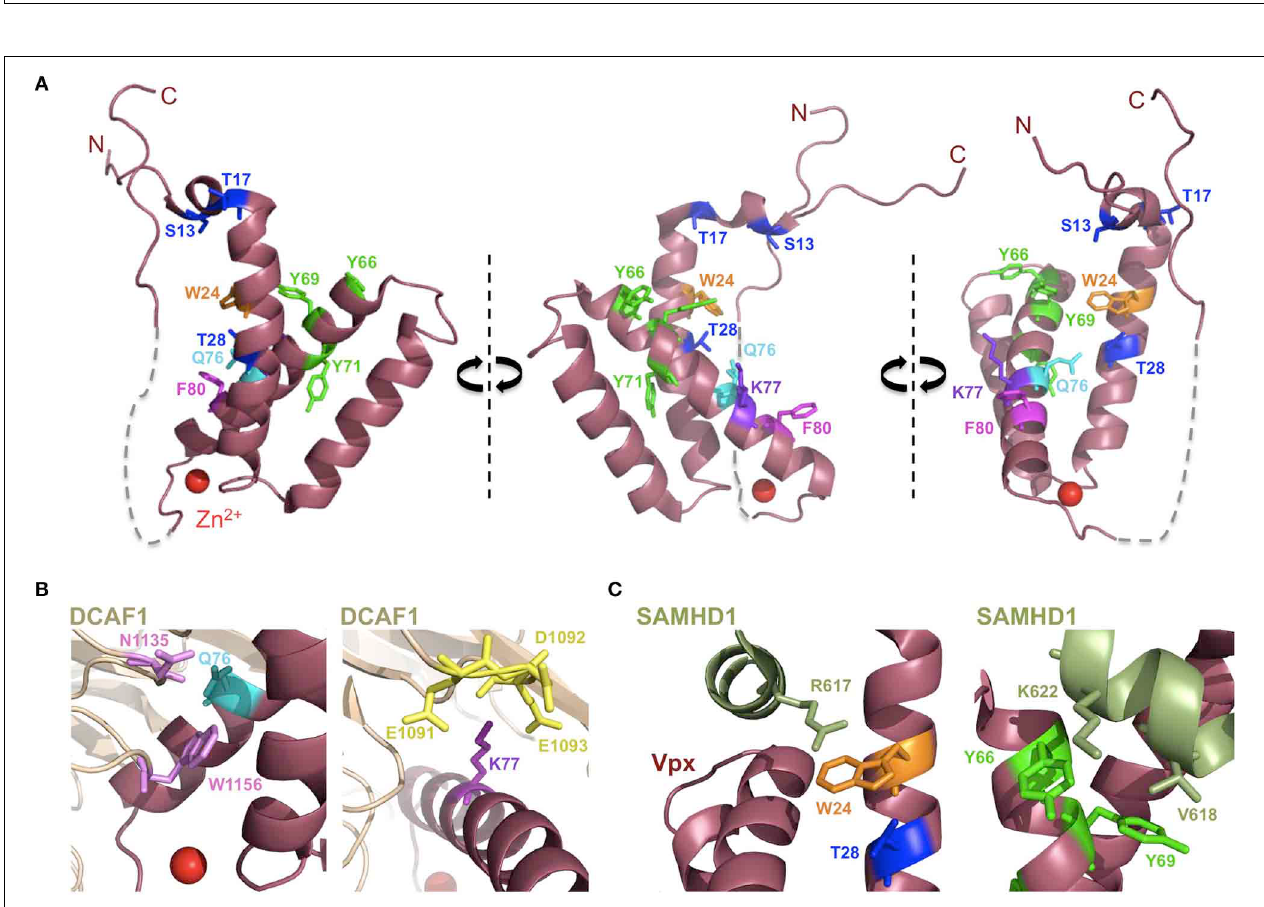
FIGURE 4 | Vpx structure. (A) Depicted is the structure of Vpx from SIVsmm as obtained in the co-crystallization with the C-terminus of DCAF1 and the C-terminus of SAMHD1 (both not shown) with critical amino acids highlighted (PDB:4CC9) (Schwefel et al., 2014). SIVsmm Vpx comprises an anti-parallel bundle of three helices, resembling the shape of a V. Vpx coordinates a zinc ion (red) with amino acids H39, H82, C87, and C89. The structure between Vpx residues 90–100 is absent (dashed gray line). (B) Critical aminoacid residues in the interface between DCAF1 and Vpx are highlighted. Vpx Q76 residue